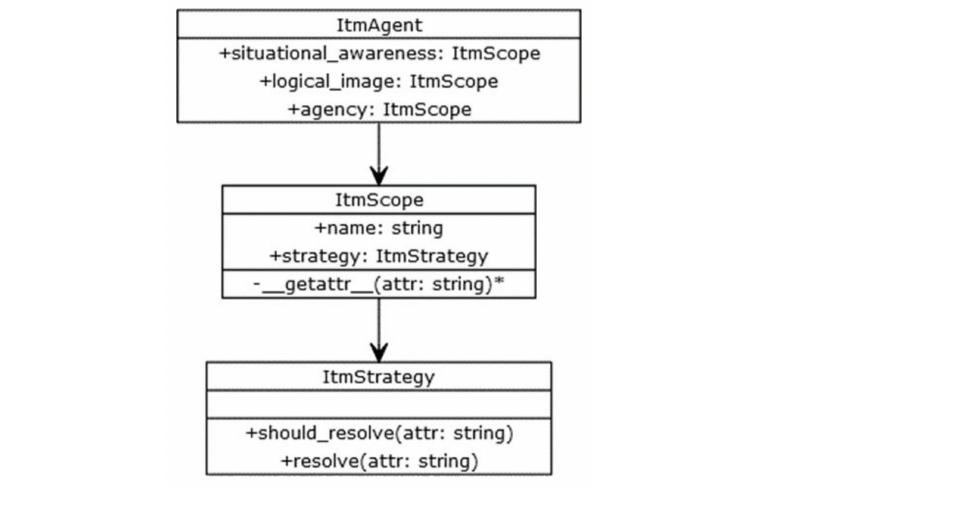
Figure 7. Simplified high-level architecture of ItmPy (an asterisk is used to indicate the method where the aspect weaving process takes place).